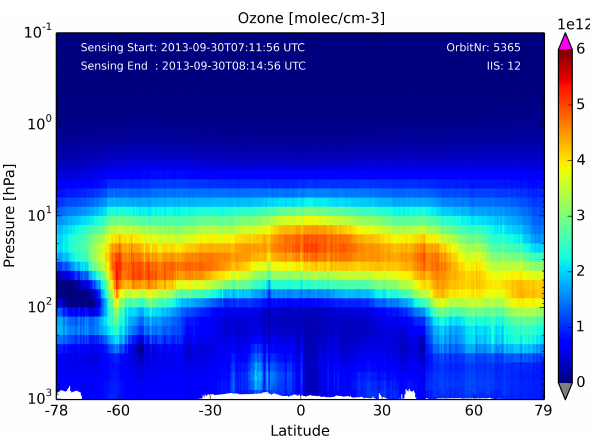
Figure 3. Vertical ozone profiles from GOME-2B, as a vertical cross section along an orbit from north to south. The measurements end in a location over the Antarctica where the Southern Hemi- sphere spring ozone hole is present, indicated by low ozone values in the